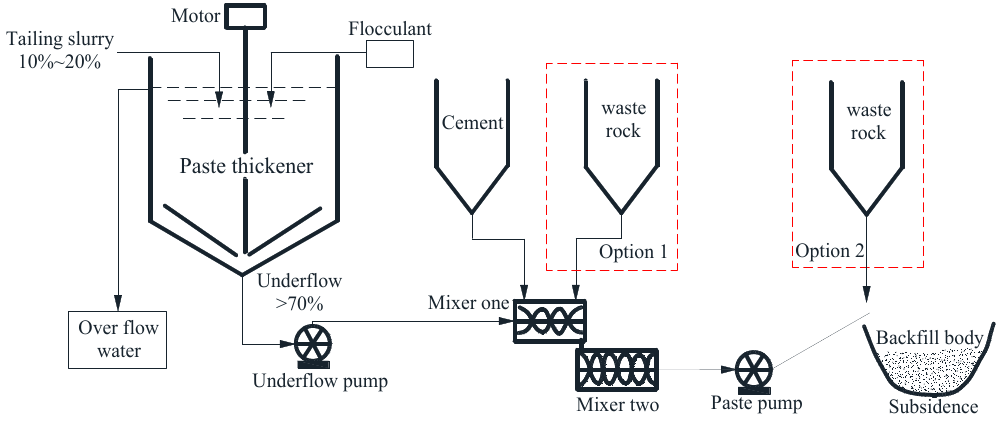
Figure 1. Technological process of subsidence control using paste backfill.